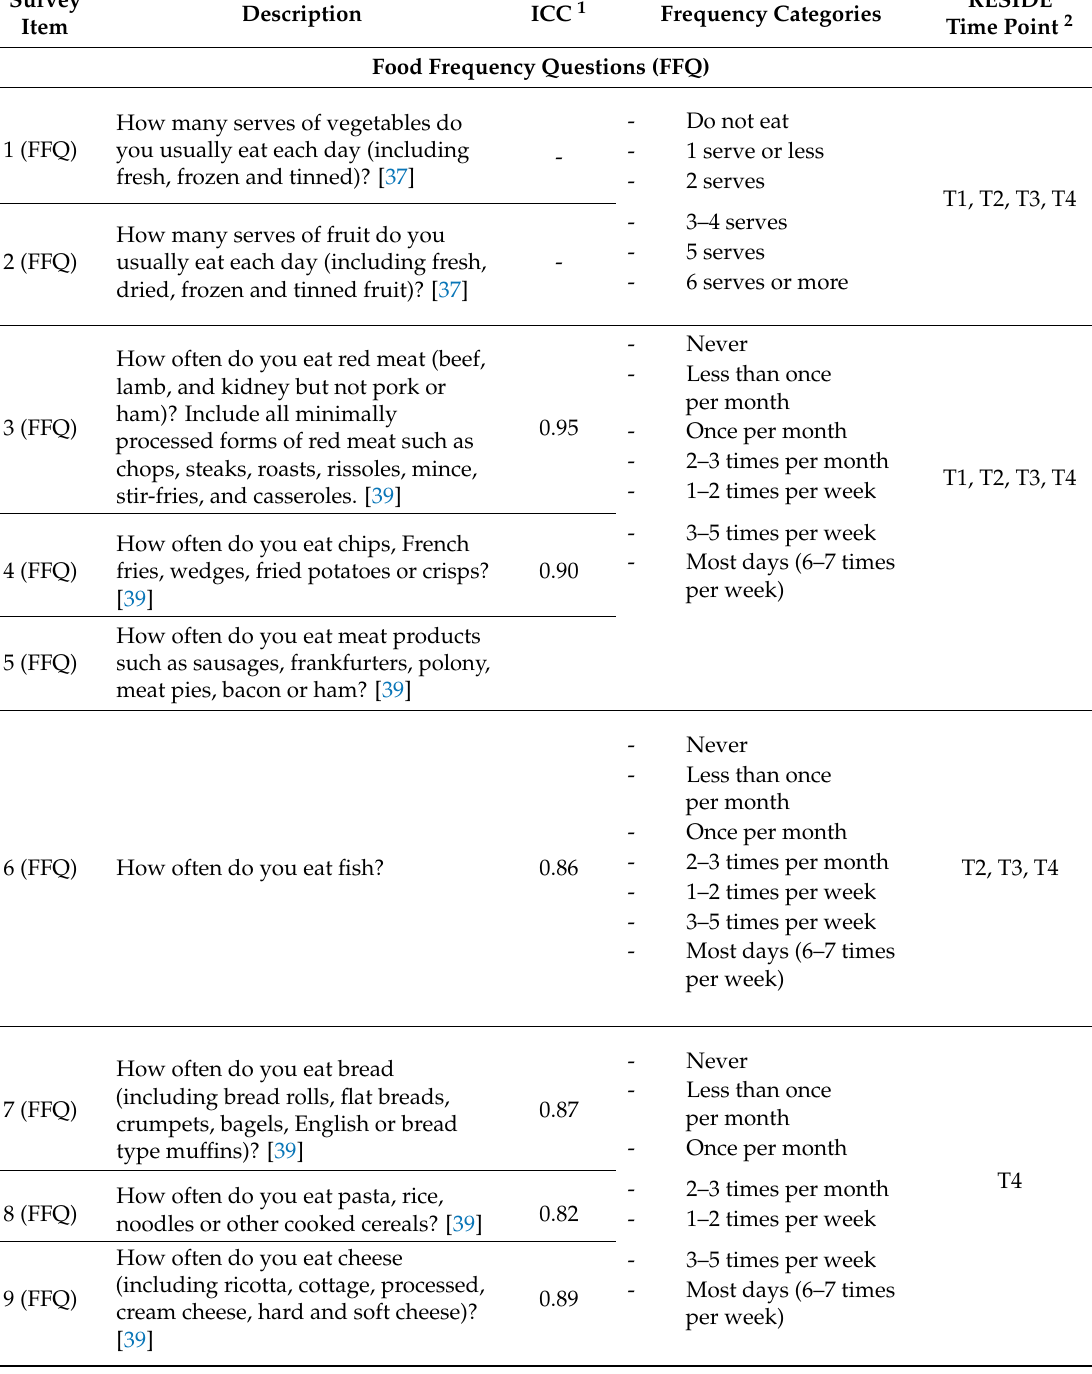
Table A1. Semi-quantitative food frequency and dietary behavior questions in the RESIDE survey.